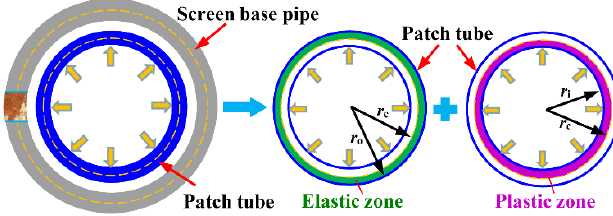
Figure 4. Elastic – plastic mechanical analysis of patch tube. Figure 4. Elastic–plastic mechanical analysis of patch